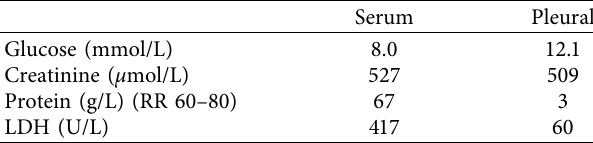
Figure 1: Chest X-ray on presentation (a) and after thoracentesis (b). Table 1: Serum and pleural biochemical markers.